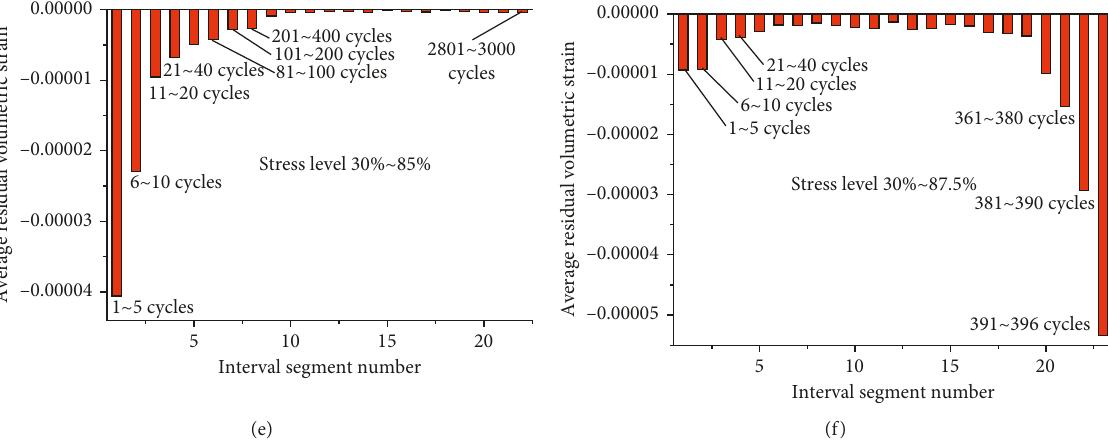
Figure 7: Average residual axial strain in different intervals at a stress level of (a) 30%–85% and (b) 30%–87.5%. Average residual cir- cumferential strain in different intervals at a stress level of (c) 30%–85% and (d) 30%–87.5%. Average residual volumetric strain in different intervals at a stress level of (e) 30%–85% and (f)